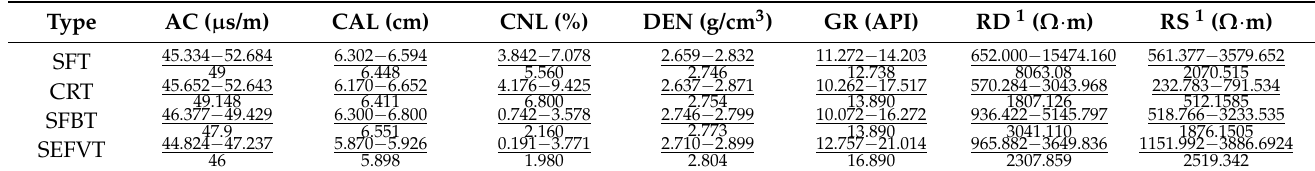
Table 1. Range and average of logging values of void space types (SFT—solution-filling type; CRT—cement-reducing type; SFBT—solution-filling breccia type; SEFVT—solution-enlarging fractures and vugs